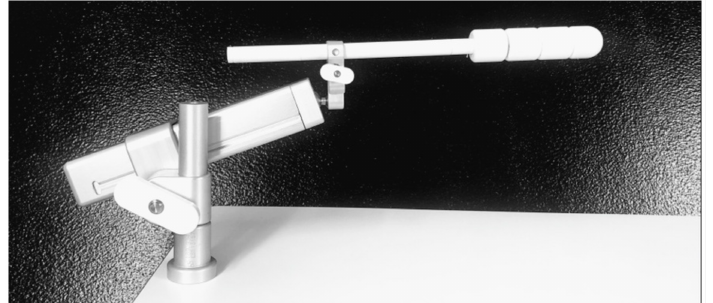
Figure 1. Cylinder vaginal applicator fixed using the fixing tray (Elekta Brachytherapy, Veenendaal, The